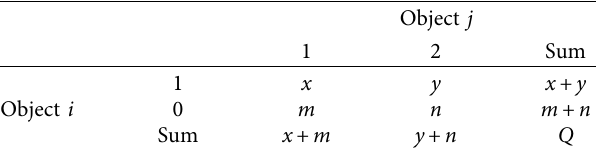
Table 1: Binary variable